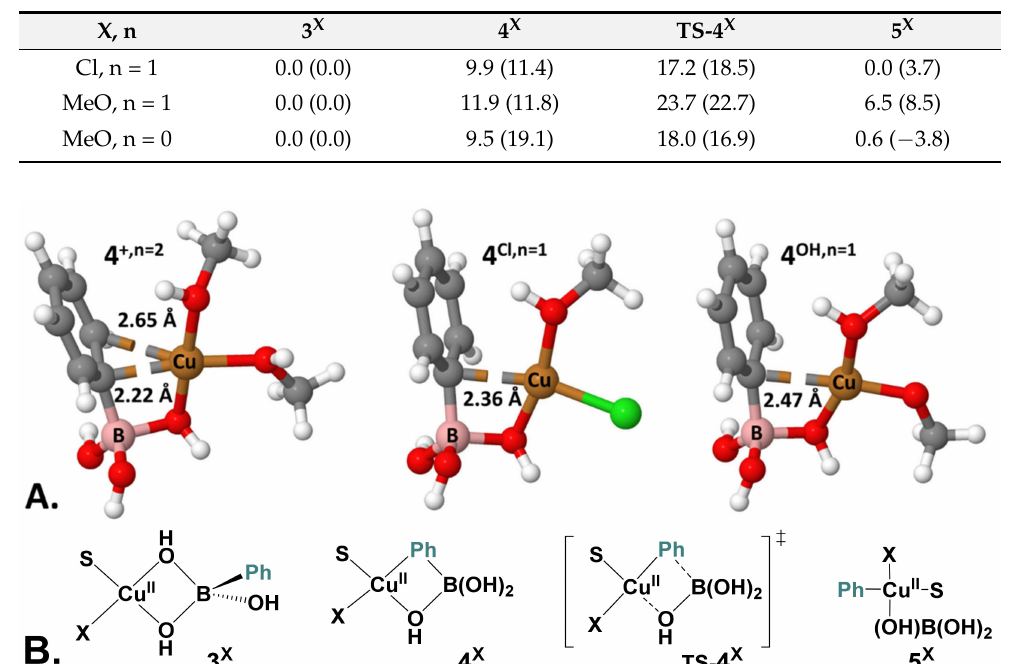
Table 1. Transmetalation paths starting from neutral heterobimetallic Cu(II)/B complexes